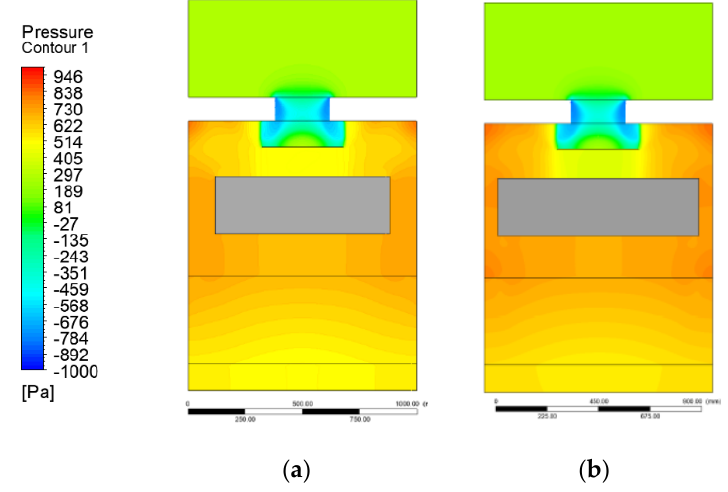
Figure 7. Pressure contour inside the AHU with ( a ) FCU1 and ( b ) FCU 2. Regarding the velocity field inside the AHU, the FCU acts as a minimizer of the swirl generated in the near-wall zones and even lower with FCU 2. Figure 8 shows the velocity contour inside the AHU with (a) FCU1 and (b) FCU 2 it is clearly seen that the FCU reduces the vorticity downstream of the fan, by comparing it with the velocity vectors obtained in Figure 6. The shrinkage between the FCU wall and the AHU wall provokes an increment in the air velocity, minimizing thus the swirl formation. By decreasing the air flow area of passage, the air velocity variation in the perpendicular direction of the AHU wall, x direction, in this case, is increased. Therefore, the shear stress in the shrinkages increase. Despite the fact that the pressure drops increases in these zones, the decreasing of dissipated energy due to swirl formation is the most significant.